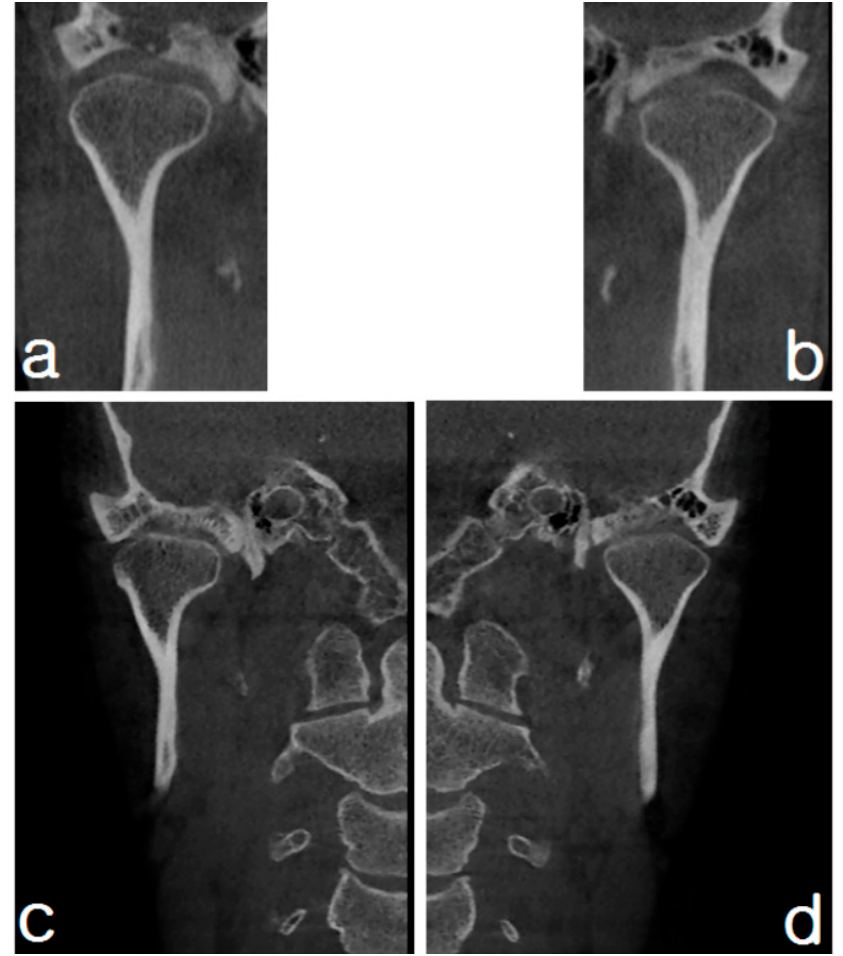
Figure 4. Temporomandibular joint cone beam computed tomography. ( a ): taken 6 months before the first visit, right condyle, incipient degenerative change; ( b ): taken 6 months before the first visit, left condyle, advanced stage of degenerative change; ( c ): taken 8 months after treatment, right condyle, no further destructive changes appeared; and ( d ): taken 8 months after treatment, left condyle, no further destructive changes appeared.